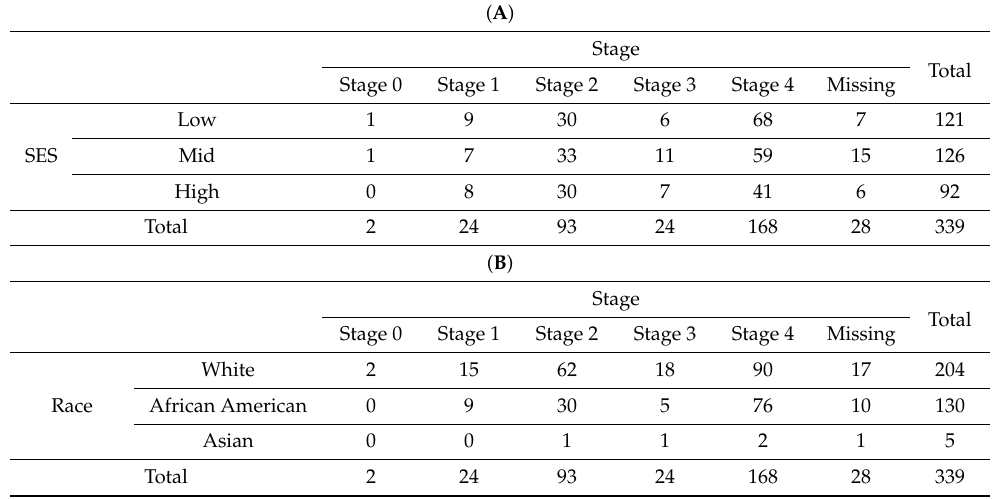
Table 6. ( A ) . Cancer stage and SES. The distribution of the number of subjects and tumor stage at the time of diagnosis. A comparative statistic for nominal data (counts) was used to detect significant differences. No significant differences were noted (chi-square, p = 0.53), indicating that stage at the time of diagnosis is not differentially distributed according to SES. Percentages are omitted for clarity. ( B ). Cancer stage and race. The distribution of the number of subjects by race and tumor stage at the time of diagnosis. A comparative statistic for nominal data (counts) was used to detect significant differences. No significant differences were noted (chi-square, p = 0.31), indicating that stage at the time of diagnosis is not differentially distributed when race was considered. Percentages are omitted for